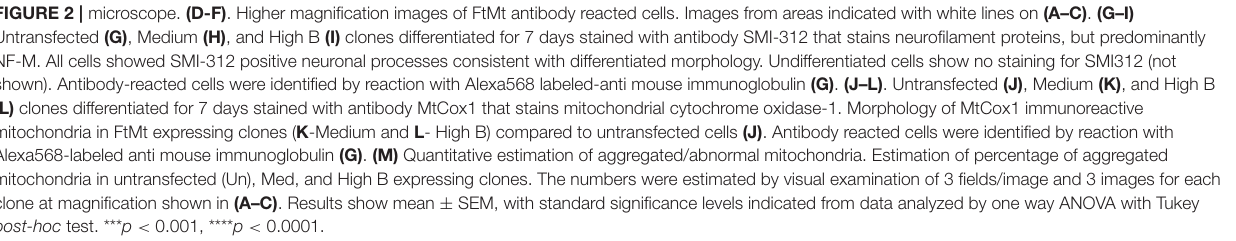
FIGURE 2 | microscope. (D-F) . Higher magnification images of FtMt antibody reacted cells. Images from areas indicated with white lines on (A–C) . (G–I) Untransfected (G) , Medium (H) , and High B (I) clones differentiated for 7 days stained with antibody SMI-312 that stains neurofilament proteins, but predominantly NF-M. All cells showed SMI-312 positive neuronal processes consistent with differentiated morphology. Undifferentiated cells show no staining for SMI312 (not shown). Antibody-reacted cells were identified by reaction with Alexa568 labeled-anti mouse immunoglobulin (G) . (J–L) . Untransfected (J) , Medium (K) , and High B (L) clones differentiated for 7 days stained with antibody MtCox1 that stains mitochondrial cytochrome oxidase-1. Morphology of MtCox1 immunoreactive mitochondria in FtMt expressing clones ( K -Medium and L - High B) compared to untransfected cells (J) . Antibody reacted cells were identified by reaction with Alexa568-labeled anti mouse immunoglobulin (G) . (M) Quantitative estimation of aggregated/abnormal mitochondria. Estimation of percentage of aggregated mitochondria in untransfected (Un), Med, and High B expressing clones. The numbers were estimated by visual examination of 3 fields/image and 3 images for each clone at magnification shown in (A–C) . Results show mean ± SEM, with standard significance levels indicated from data analyzed by one way ANOVA with Tukey post-hoc test. *** p < 0.001, **** p <